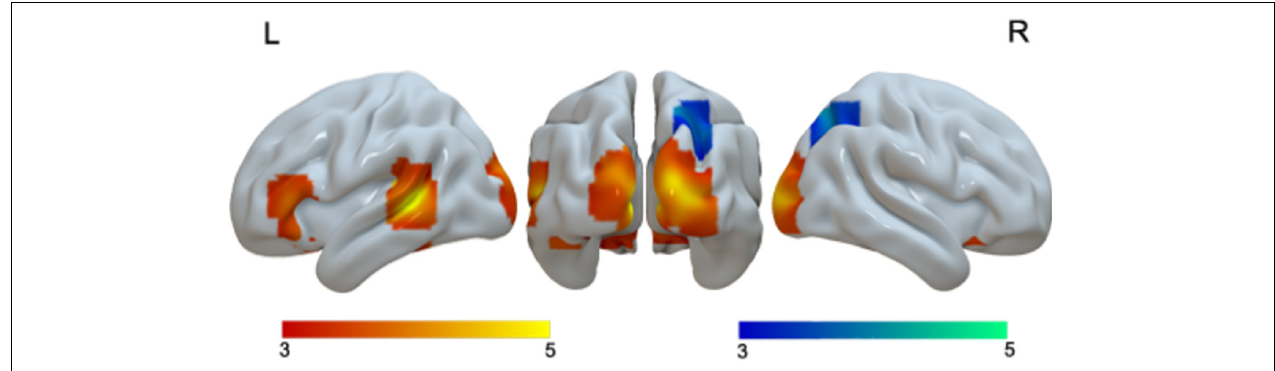
FIGURE 1 | Brain activation in the main effect of language. Brain regions that were more activated in Chinese than in English are in red; brain regions that were more activated in English than in Chinese are in blue.